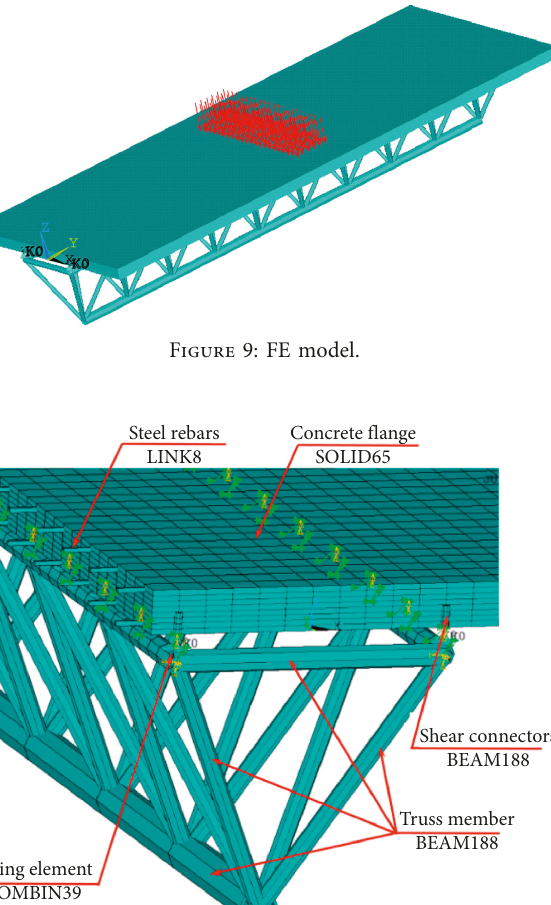
Figure 10: FE mesh.